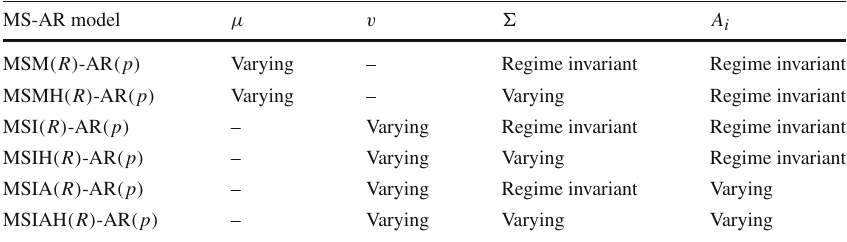
Table 1 Types of MS-AR models. Source: author’s calculations based on Krolzig (1997) MS-AR